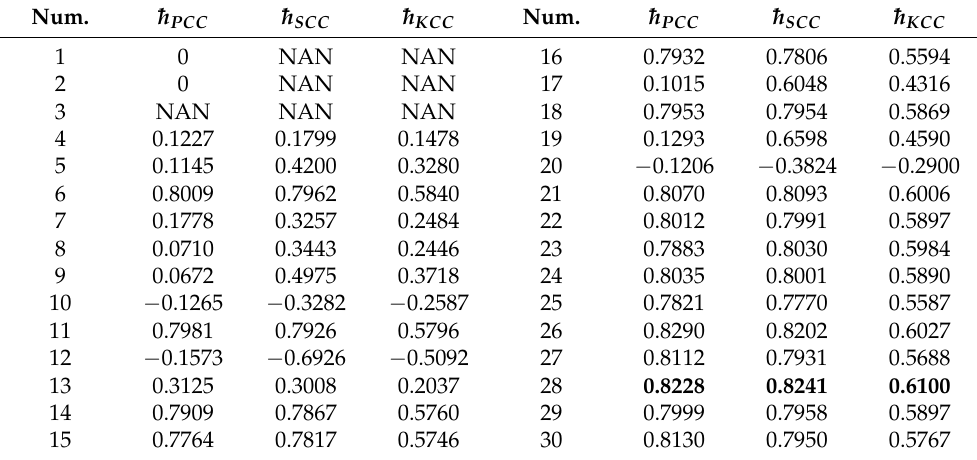
Table 2. The performance of the FNN-based PM 2.5 concentration monitoring model with the different number of hidden layers on the AQID. The reason for the numbers 0 and NAN in Table 2 is that the shallow hidden layer leads to the difficult convergence of model